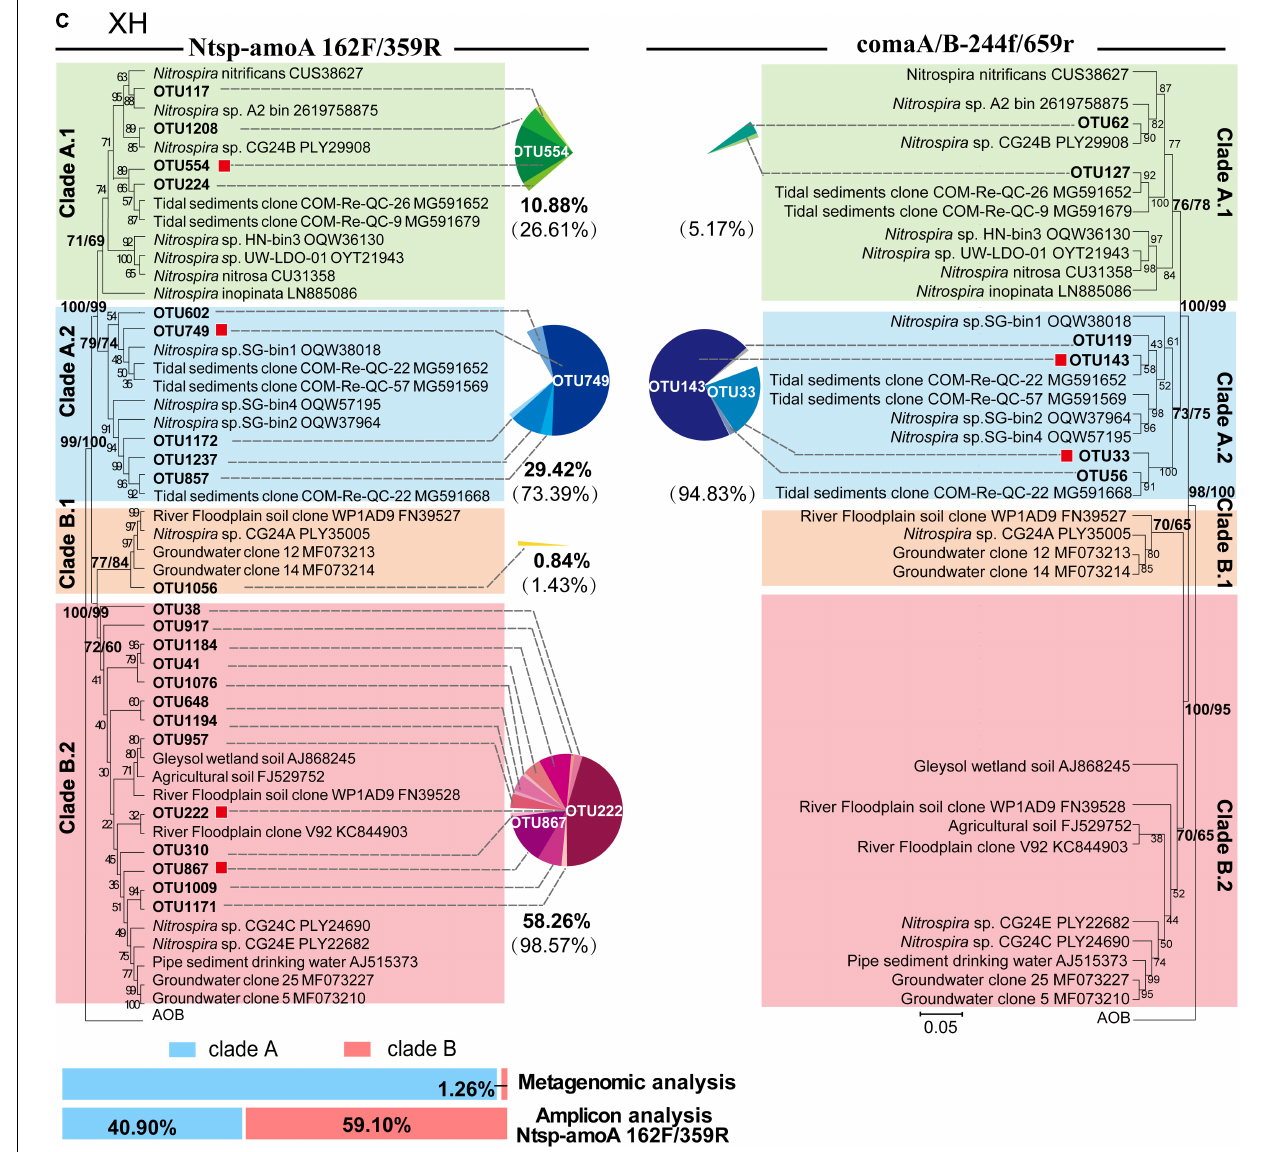
FIGURE 4 | Maximum-likelihood phylogenetic trees based on representative sequences of the OTUs (RA > 0.5% of each sample) and 77 reference sequences using Ntsp-amoA 162F/359R (left) and comaA/B-244f/659r (right) from panel (A) SS, (B) SJ, and (C) XH samples. A Sequence from betaproteobacterial amoA was used as a outgroup. Bootstrap values in the maximum-likelihood and phylogenetic neighbor-joining trees calculated based on 1,000 trials were separated by a slash. Sequences obtained in this study were marked in bold. Red squares indicate the OTUs that its RA was larger than 0.5% of each clade. Sequences obtained from different clades are indicated by color symbols for clade A.1 (green), clade A.2 (blue), clade B.1 (orange) and clade B.2 (pink). Pie charts illustrate the proportion of OTUs in each clade with the bold data under the pie chart presenting the account of each group in the total sequences that RA was larger than 0.5%. The data in parentheses indicate the proportion of each group in clade A or B. Metagenomics and amplicon (Ntsp-amoA 162F/359R) results of clade A (blue) and B (red) proportion in each sample are in the lower-left